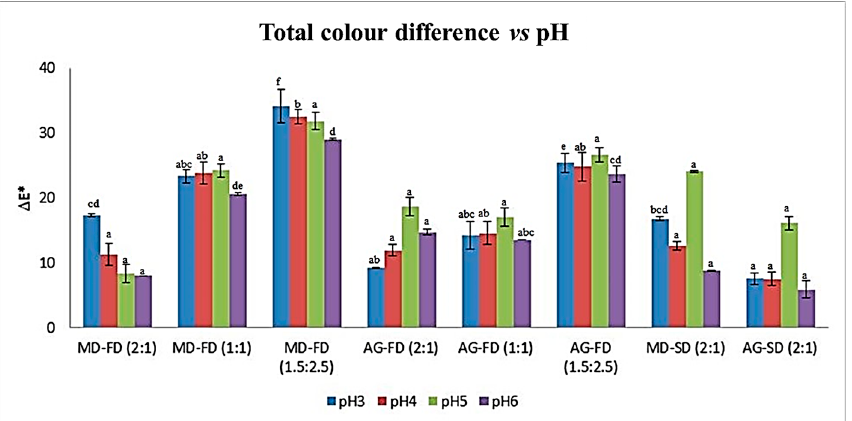
Figure 2. Total colour difference ( ∆ E*) for the red dye extract non-encapsulated (NE) and extracts encapsulated with maltodextrin (MD) and Arabic gum (AG) obtained by freeze-drying (FD) and by spray-drying (SD) (mean ± SD). Different letters indicate significant differences ( p < 0.05) within the same ratio for carrier agents and the encapsulation process.